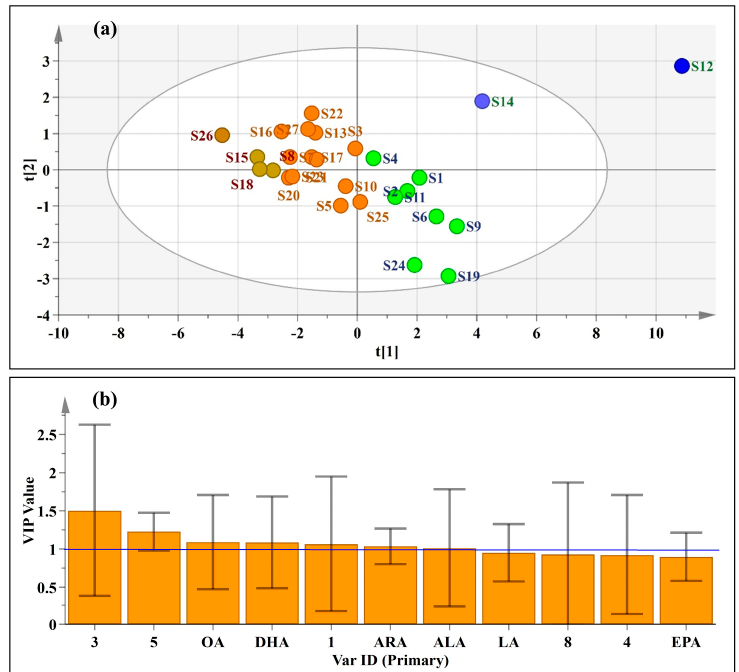
Figure 10. Supervised pattern recognition model. ( a ) partial least squares linear analysis (PLS-DA) score scatter plot of 27 batches of Oviductus Ranae , ( b ) The variable important for the project (VIP) plot of PLS-DA.